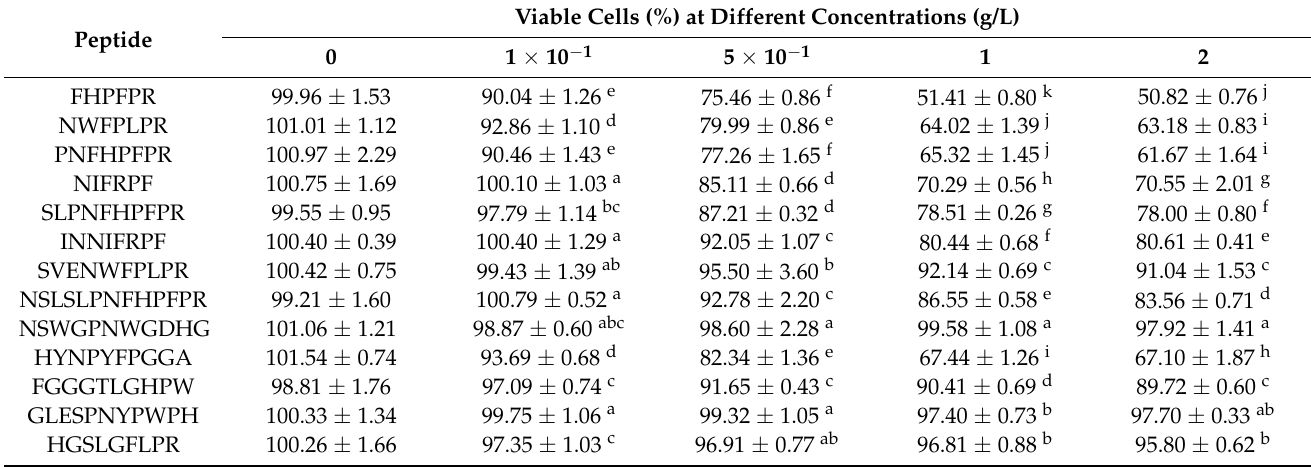
Table 2. Dose-dependent effects of quinoa peptides released from gastrointestinal digestion on cell